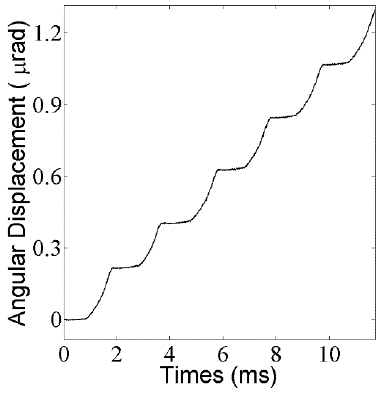
Figure 9. Results from the experiment.